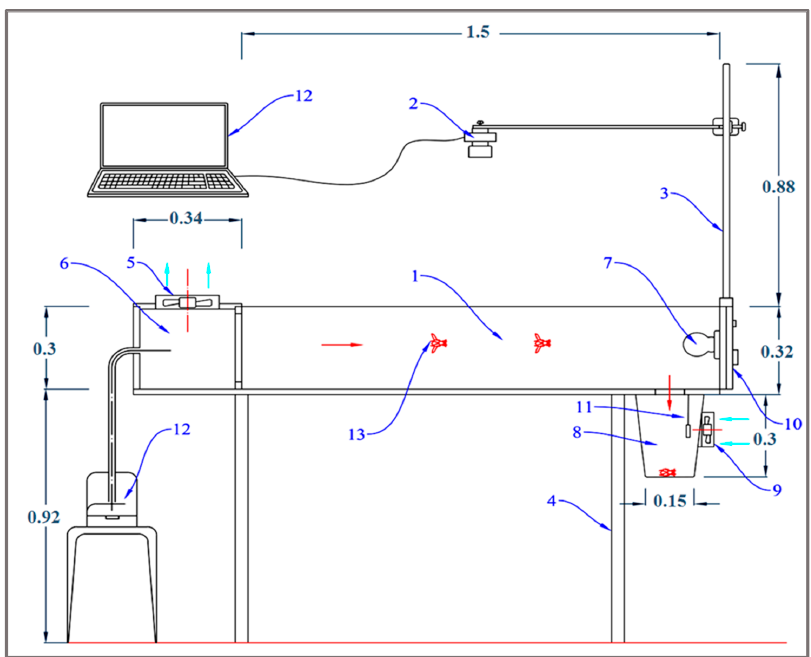
Figure 11. Schematic diagram of the front view of the flight-testing tunnel. ( 1 ) Flight tunnel made from transparent polyvinyl chloride transparent sheets (PVC), ( 2 ) digital camera, ( 3 ) holder, ( 4 ) metal stand, ( 5 ) fan for air suction, ( 6 ) chamber of insect, ( 7 ) light source, ( 8 ) plastic box for insect collection, ( 9 ) small fan for spread the pheromone scent, ( 10 ) control panel, ( 11 ) laptop ( 12 ) humidifier, ( 13 ) tested red palm red palm weevil (RPW). Sensors 2021 , 21 , x FOR PEER REVIEW